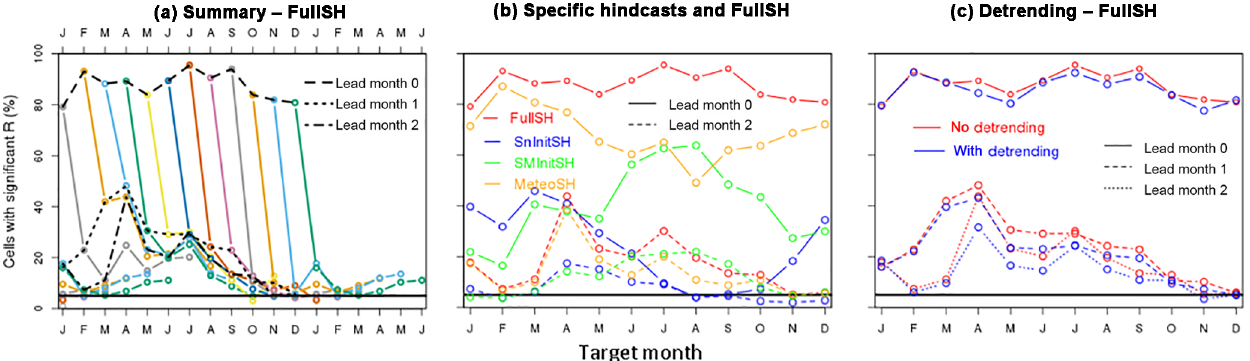
Figure 9. Summary plots of the skill of the hindcasts of evapotranspiration. (a) summarises the FullSHs (for more explanation, see Fig. 1b), (b) depicts the annual cycles of skill for the FullSHs and three specific hindcasts (SnInitSHs, SMInitSHs and MeteoSHs), for lead months 0 and 2, and (c) compares the annual cycles of skill of the un-detrended and the detrended FullSHs for the first 3 lead months.